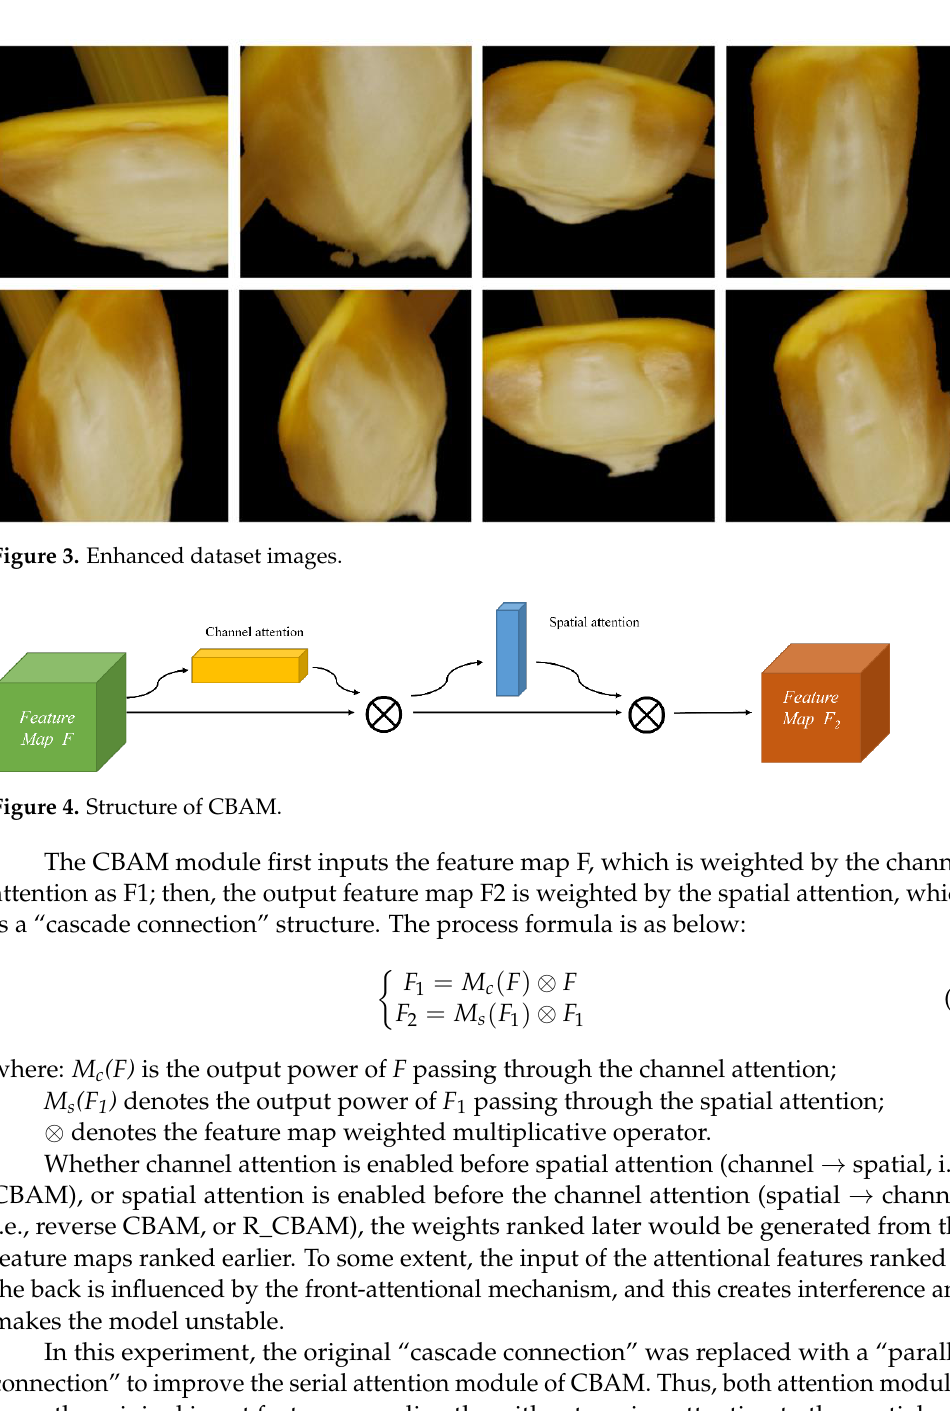
Figure 4. Structure of CBAM.